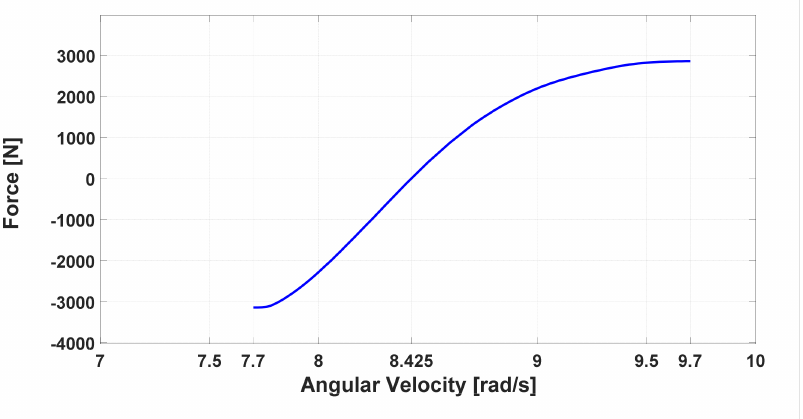
Figure 14. Longitudinal force vs. angular velocity for the calculation of the effective rolling